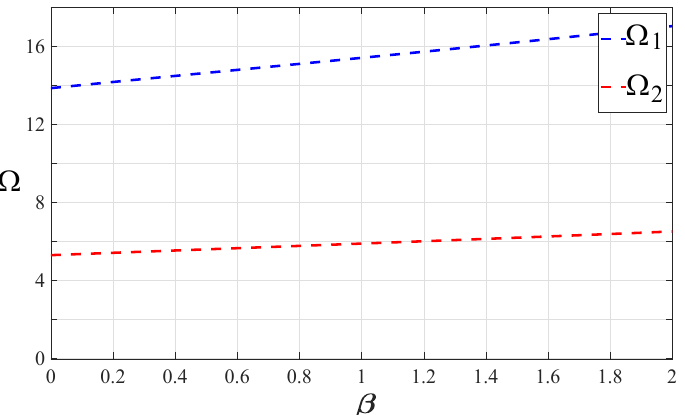
Figure 12. The variation of the two dimensionless natural frequencies with inerter–mass β under µ =